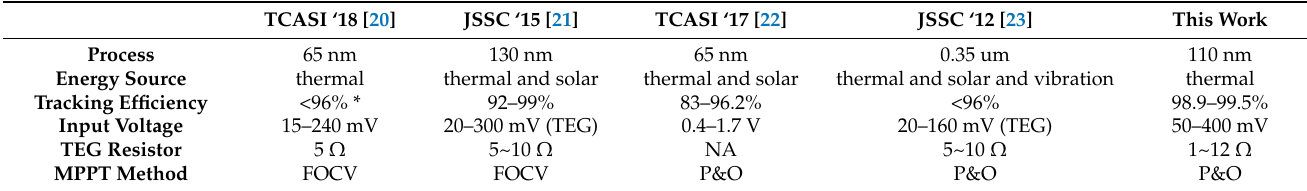
Table 1. Performance comparisons with related